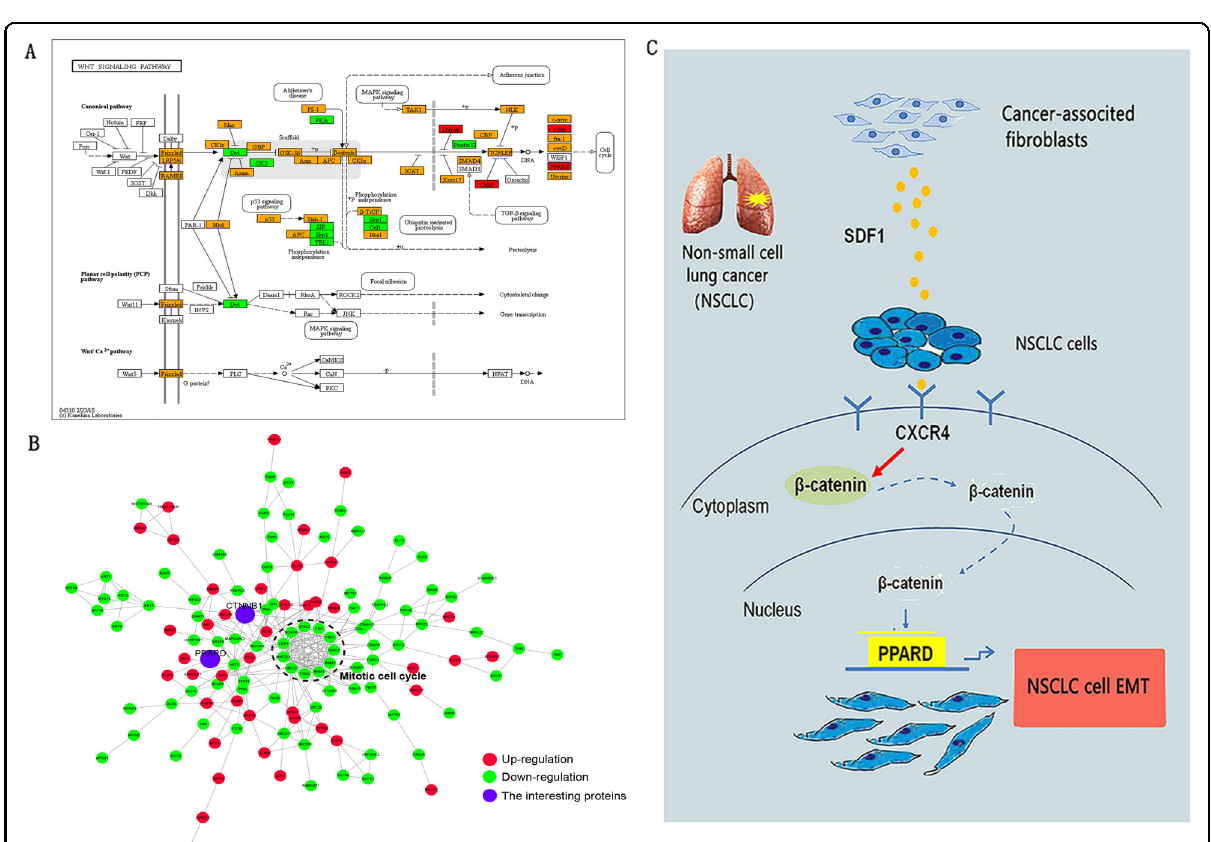
Fig. 4 Analysis of the mechanism of lung ADC EMT induced by CAF-secreted SDF-1 using proteomics and bioinformatics. a Kyoto Encyclopedia of Genes and Genome (KEGG) pathways of different proteins related to β -catenin in EMT-A549 cells. b Molecular model map of differential genes related to the β -catenin pathway in EMT-A549 cells. c Schematic diagram showing the potential mechanism by which CAF- secreted SDF-1 mediates EMT in lung ADC